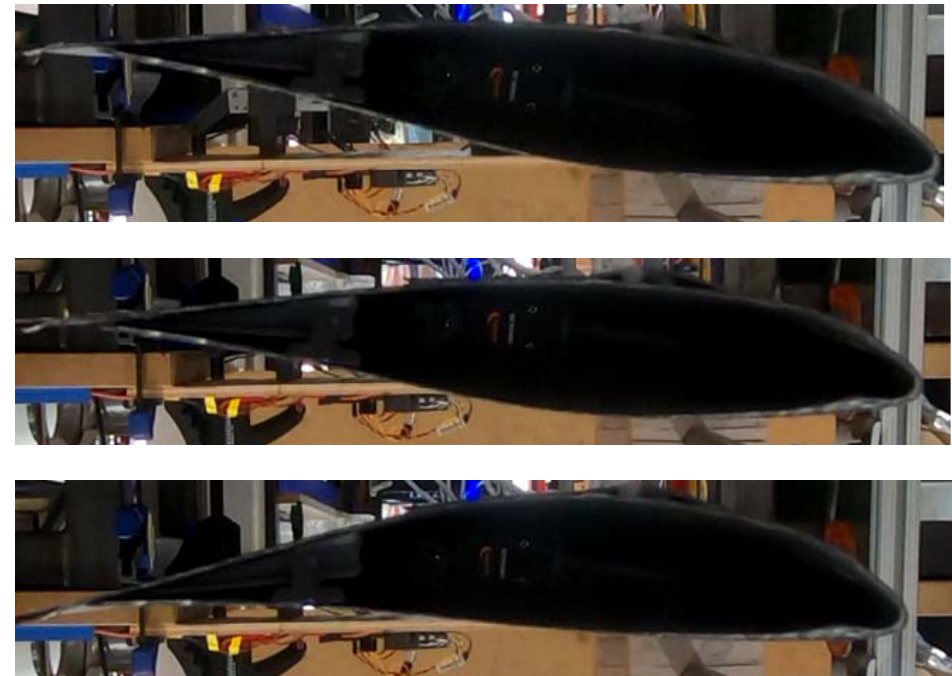
Figure 4. Tip airfoil under different spanwise actuation distributions.